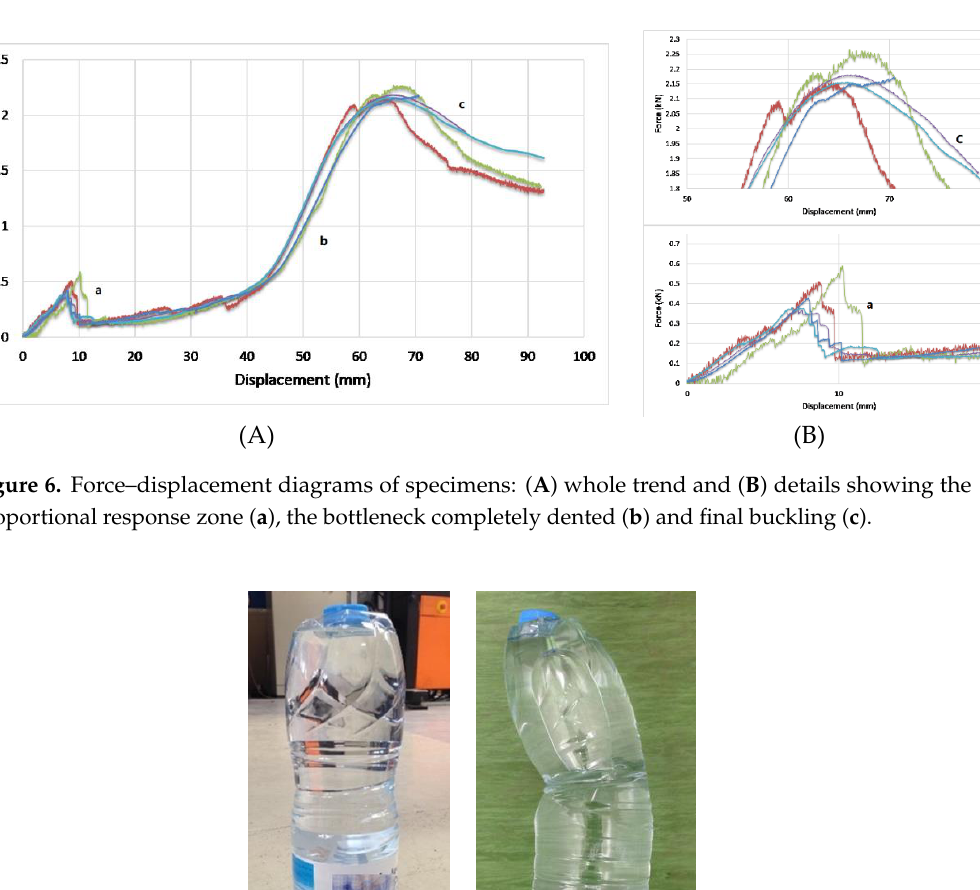
Figure 5. Predominance of buckling on single-bottle compression tests: initial part of the test with a proportional response ( a ), as soon as the bottleneck is completely dented ( b ), and near to the 3% strain region when buckling takes place ( c ).